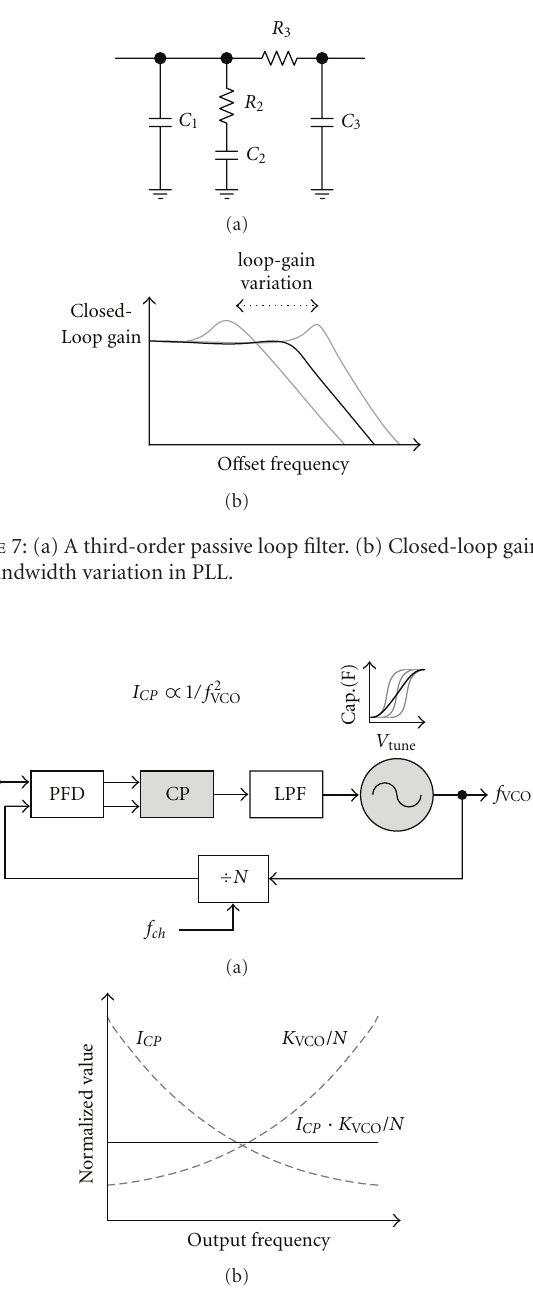
Figure 10: PLL block diagram with the FDC-based autocalibration